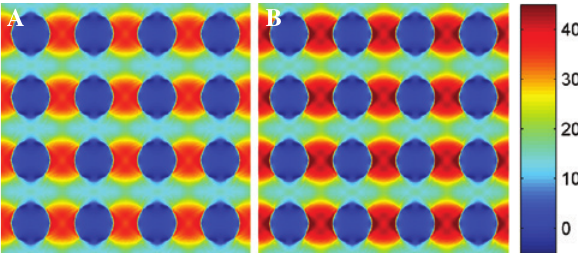
Figure 7: Hydrostatic stress fields at applied transverse strain of 1.5% at strain rates of (A) 0.1/s and (B)